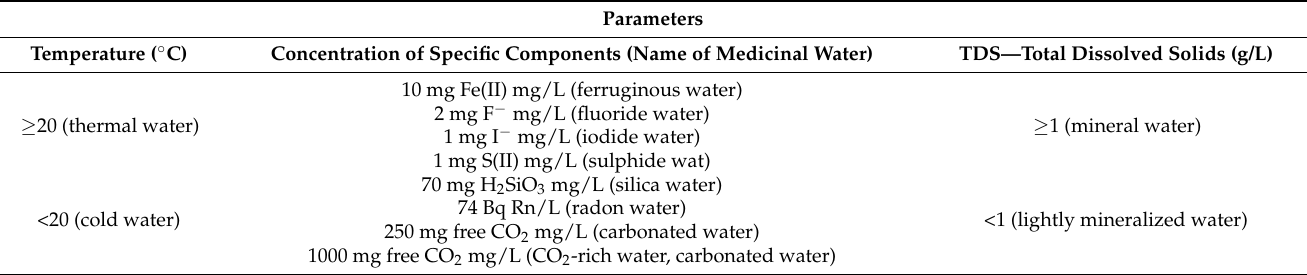
Table 1. Minimal concentrations of specific components and temperature of water and TDS for medicinal water classification (based on [74]).